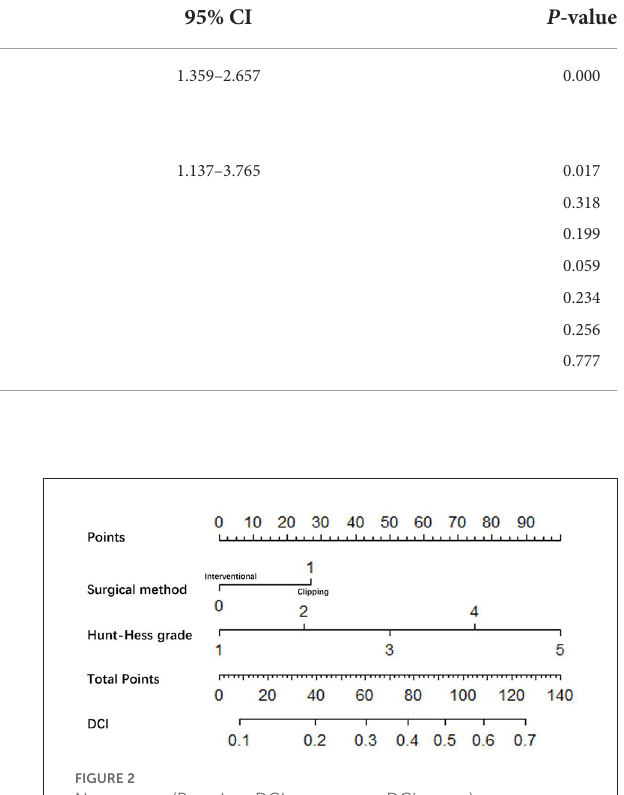
TABLE 3 Multivariable logistic analysis (Based on DCI group, non-DCI group).